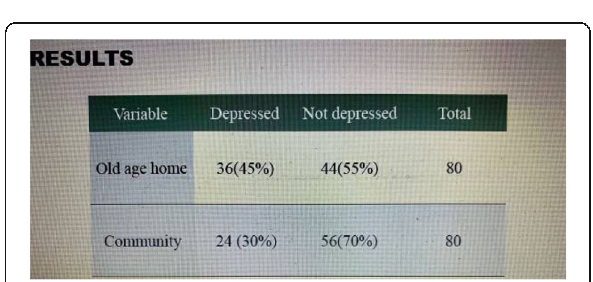
Fig. 2 (abstract P0486). See text for description